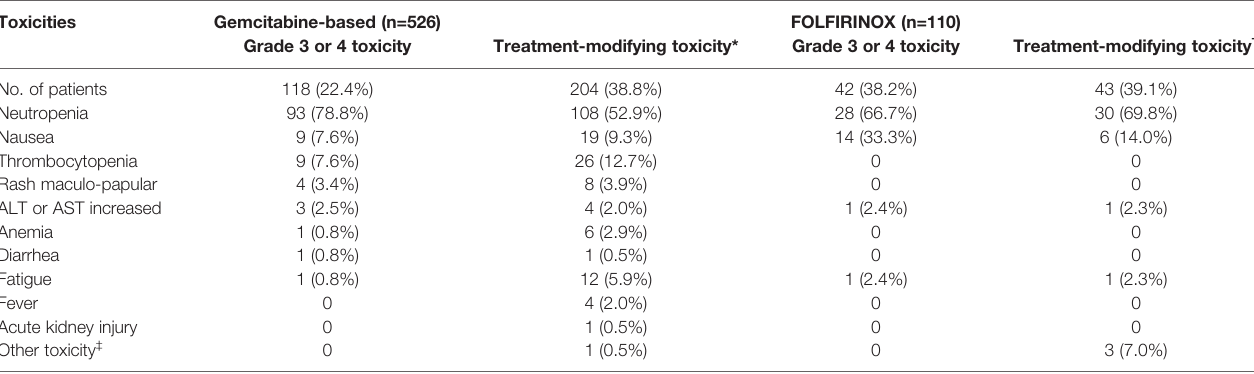
TABLE 2 | Toxicity during the fi rst cycle of fi rst-line